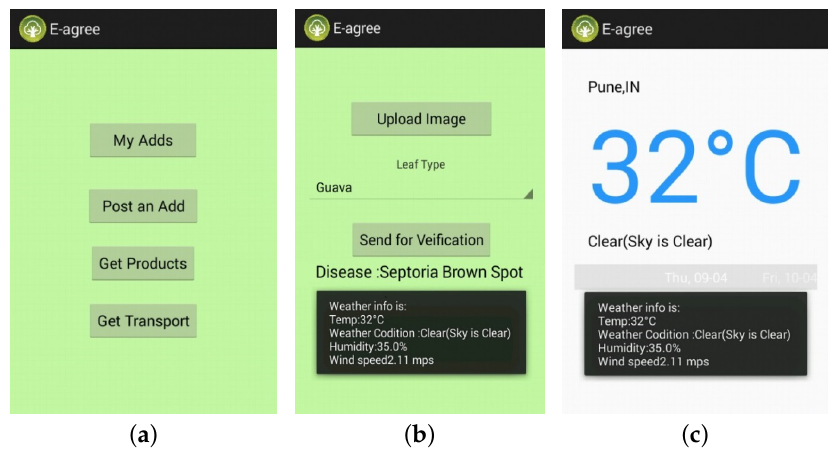
Figure 4. E-agree: ( a ) Main menu; ( b ) Image upload and verification; ( c ) Weather report.